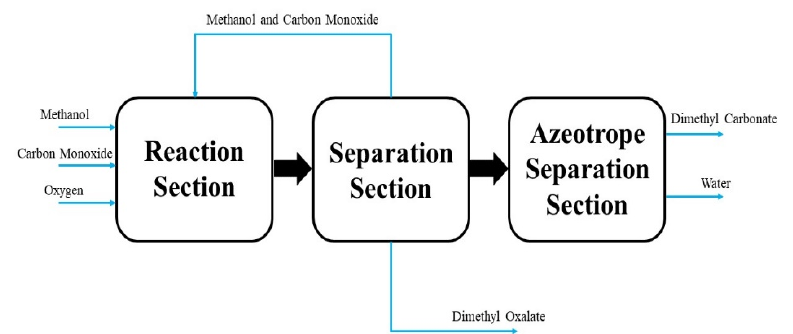
Figure 5. Block flow diagram (BFD) for the production of DMC and DMO via the oxidative car- bonylation of MeOH.